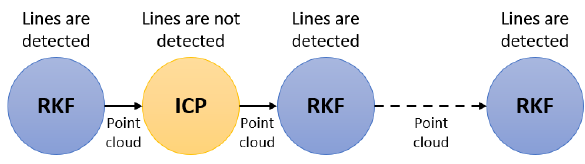
Figure 1. Alternating structure of the RKF algorithm.